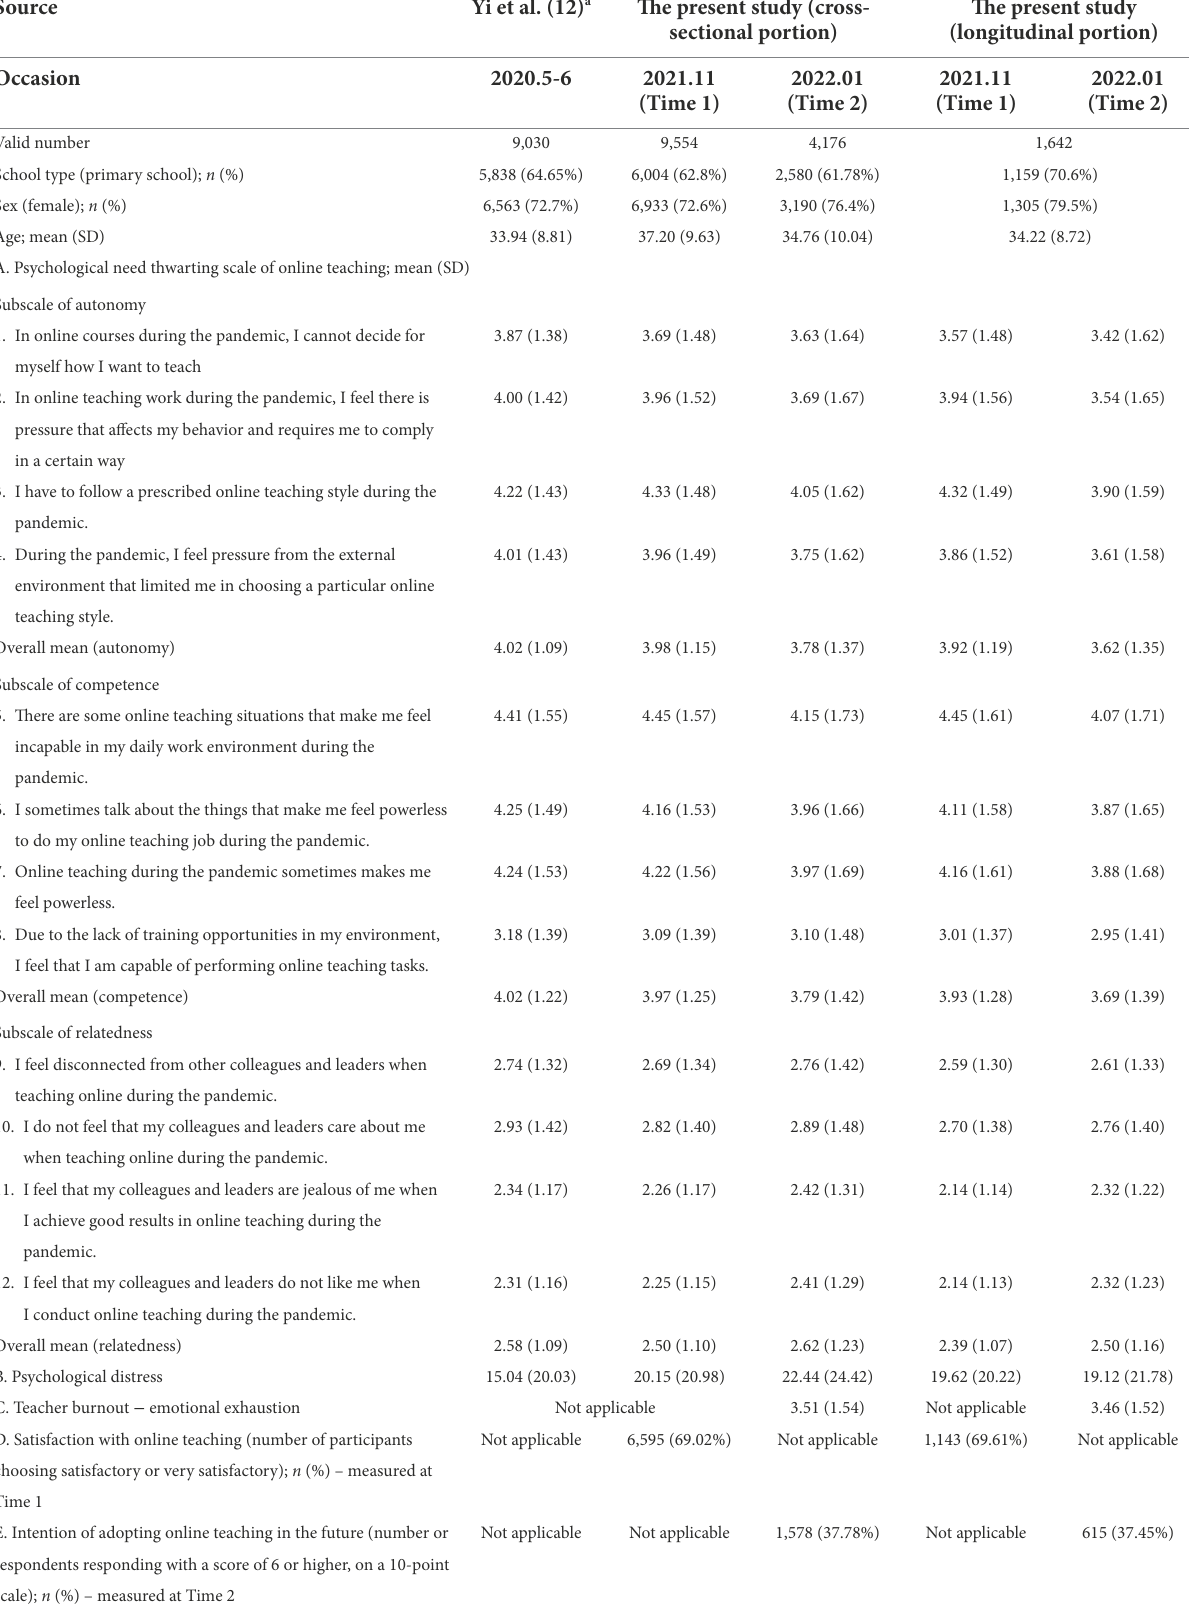
TABLE 1 Demographics of the participants and the descriptive statistics of the observed variables. Source Yi et al. (12) a The present study (cross-